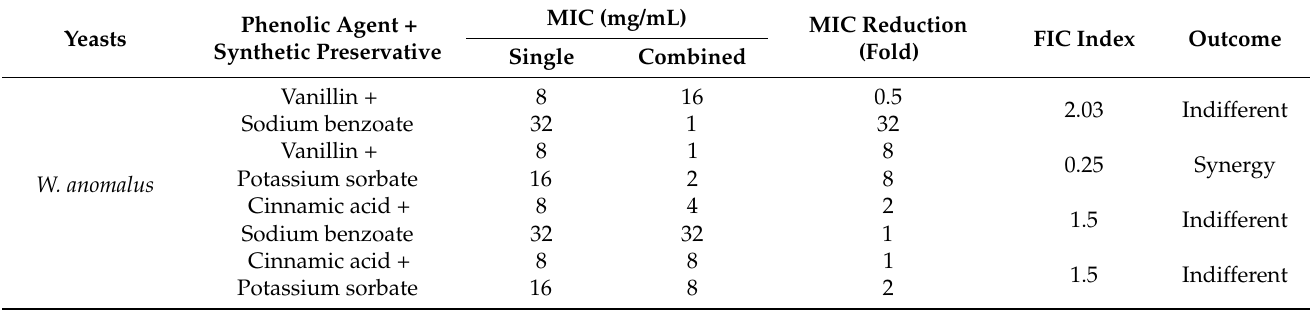
Table 6. Effect of combination of phenolic compounds and synthetic preservatives on polystyrene surface adhesion of food spoilage